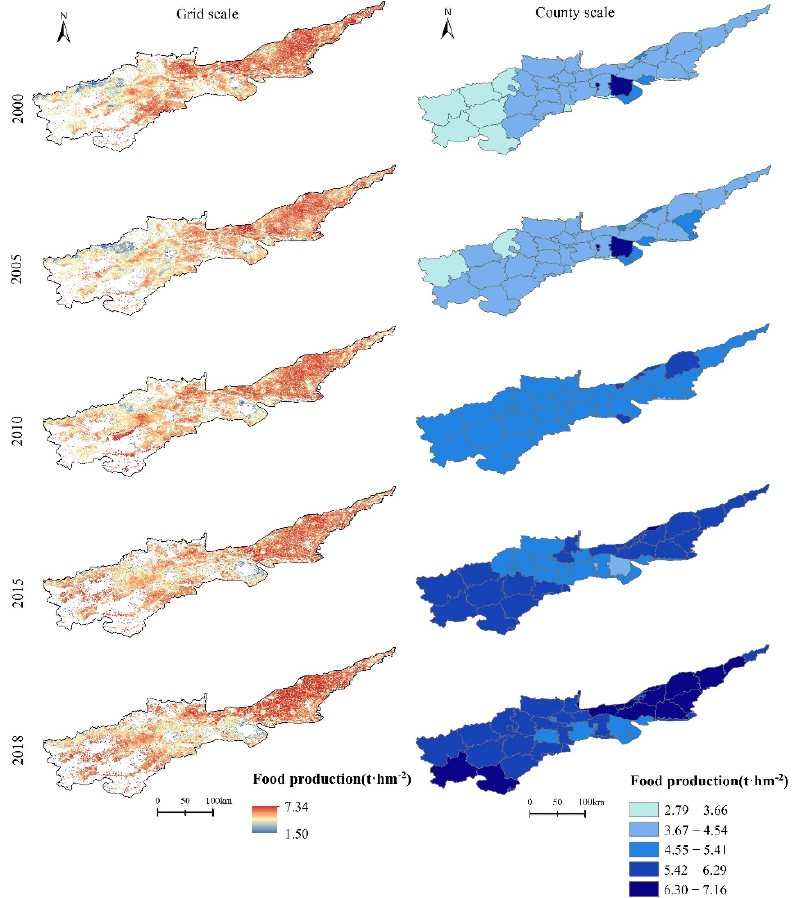
Figure 6. Spatiotemporal distribution patterns of food production in the AYRHP on raster and county scales.